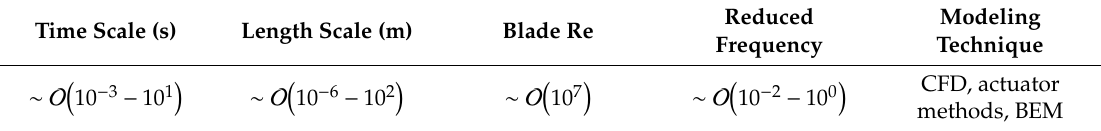
Table 1. Range of scales and modelling techniques for full-scale wind turbines.